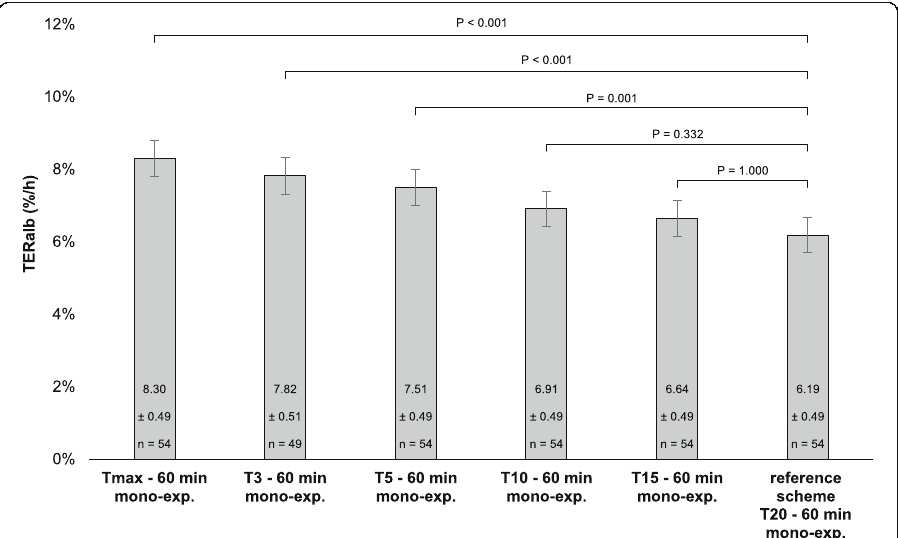
TER alb based on mono-exponential kinetic analysis